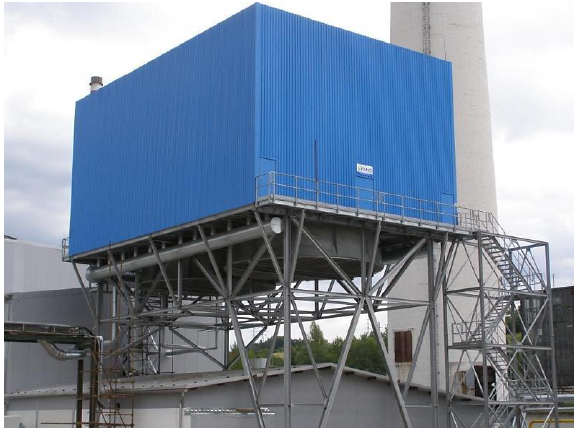
Fig. 7. Picture of real ACC system